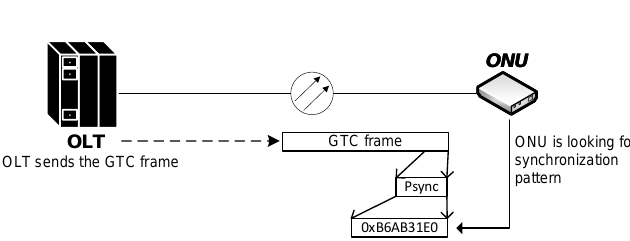
Figure 7. Activation process of ONU in a GPON network with PLOAM message details for state